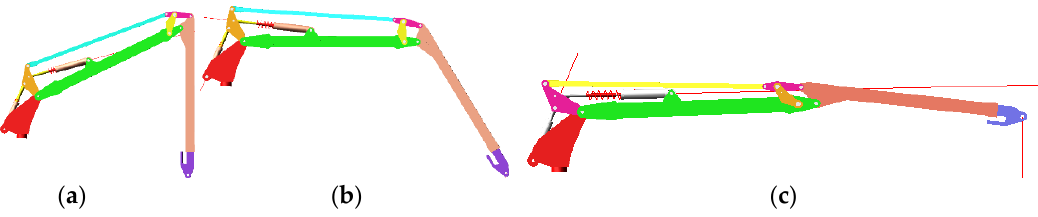
Figure 3. The main cylinder luffing and three typical operation conditions. ( a ) working condition 1; ( b ) working condition 2; ( c ) working condition 3.